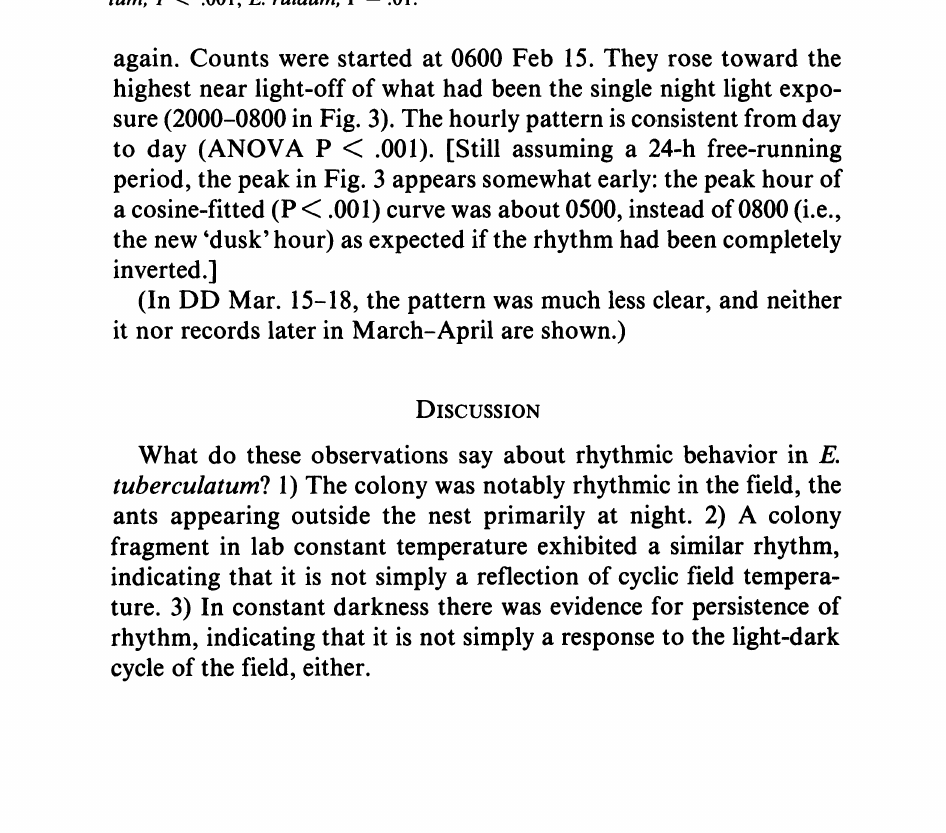
Fig. 2. LD arena rhythm of group of workers from BCI colony. Ants out in arena, mean + SE, days as replicates (one-way ANOVA), Mar. 10-14. E. tubercula- turn, P .001; E. ruidurn, P